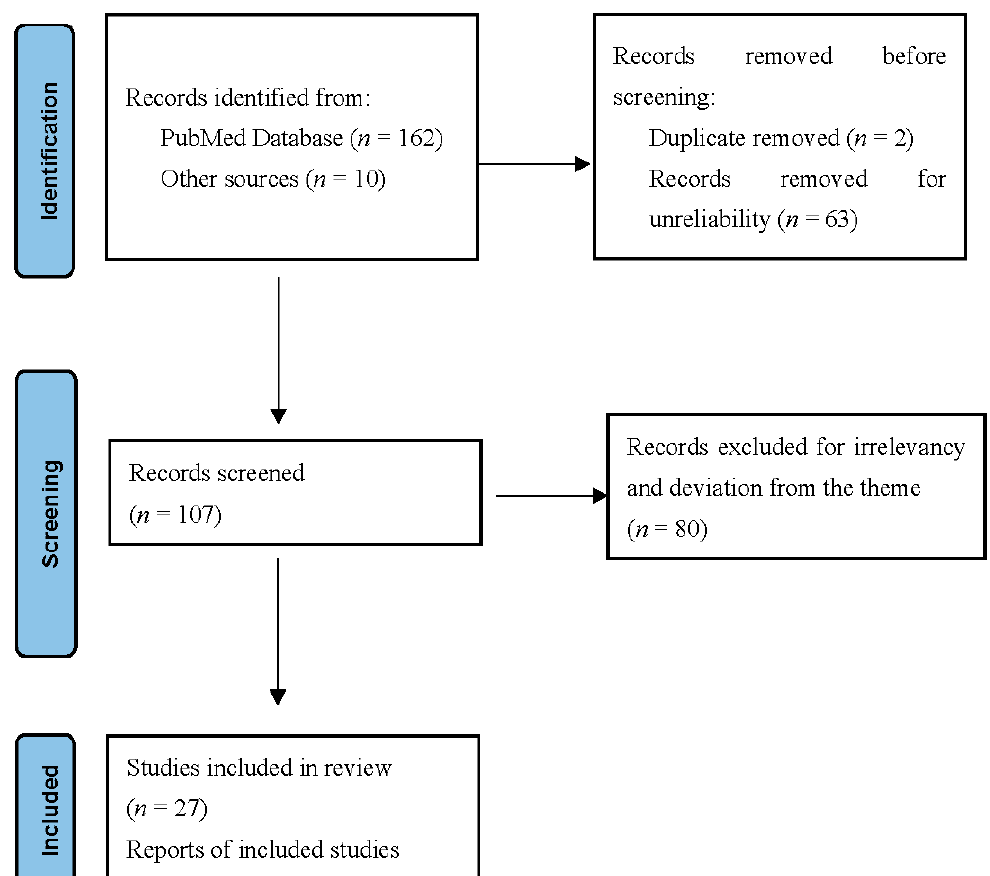
Figure 1. Identification of studies. Inclusion and exclusion criteria adopted for this research.